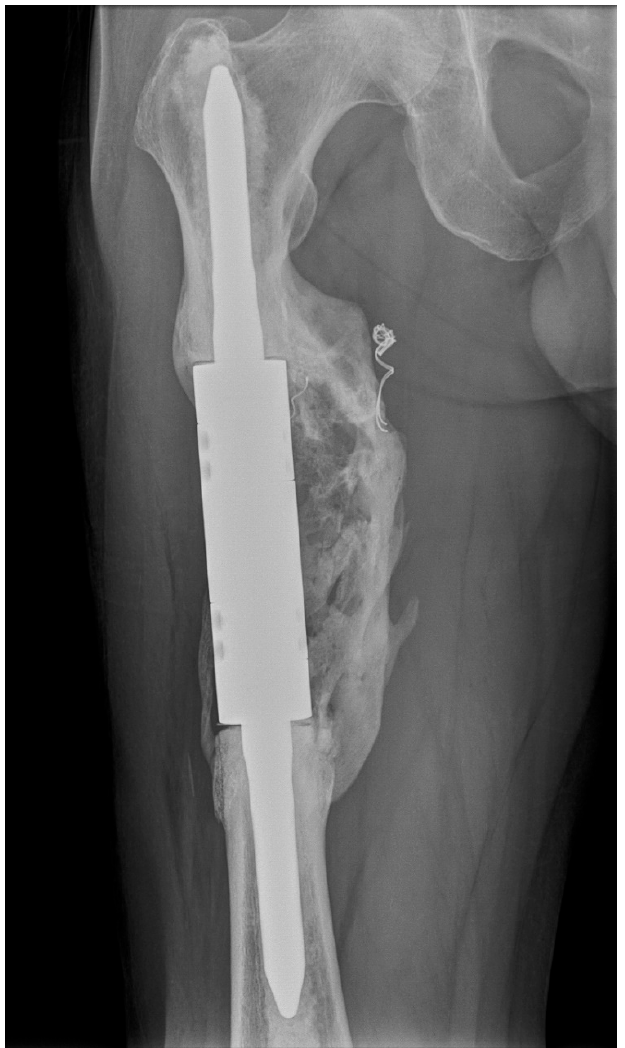
Figure 6. X-ray image of an intercalary endoprosthesis with the formation of heterotopic ossification around the implant after the resection of a renal cell carcinoma metastasis, with a bone bridge connecting the proximal and distal bone fragments. This image is from patient 1 in Table 1.